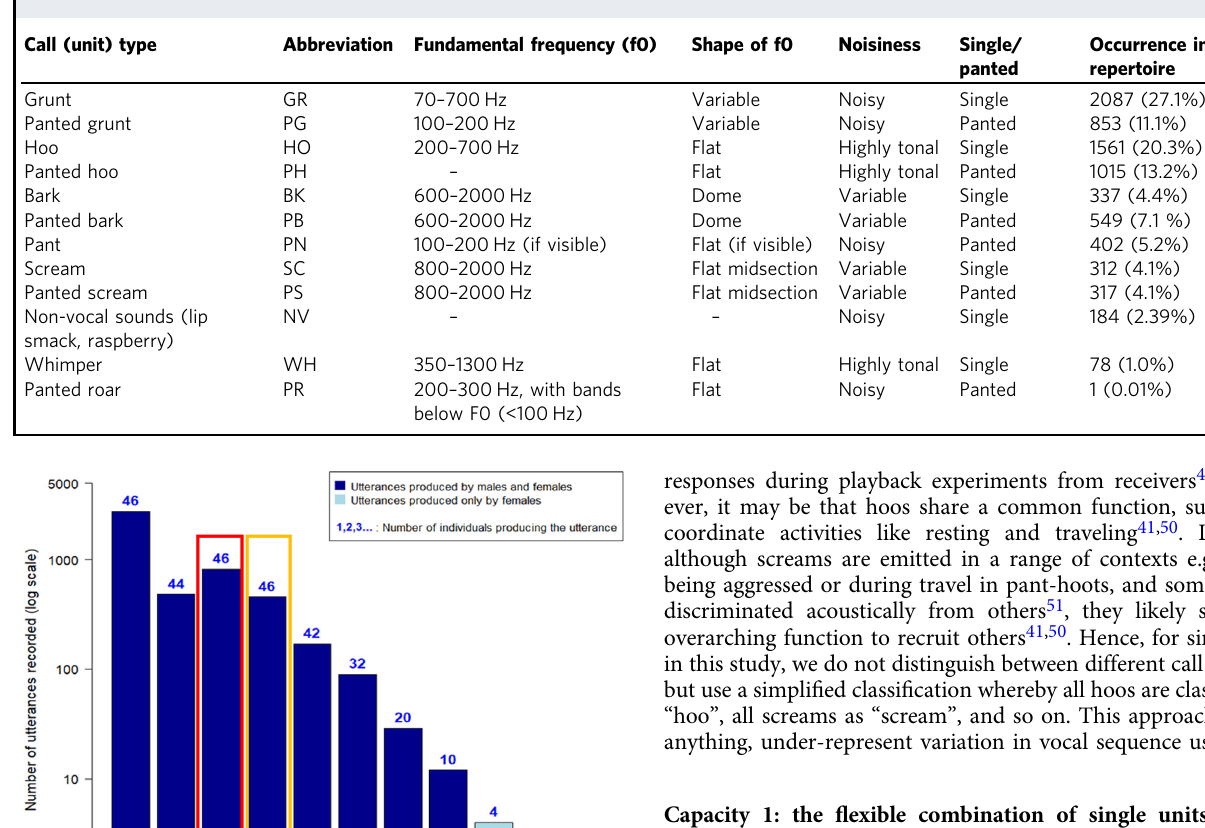
Table 2 Discrimination of chimpanzee call types.